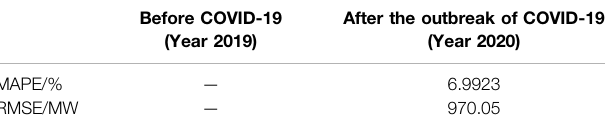
TABLE 4 | Forecasting performance of ResGCN with load graph encoding heterogeneous